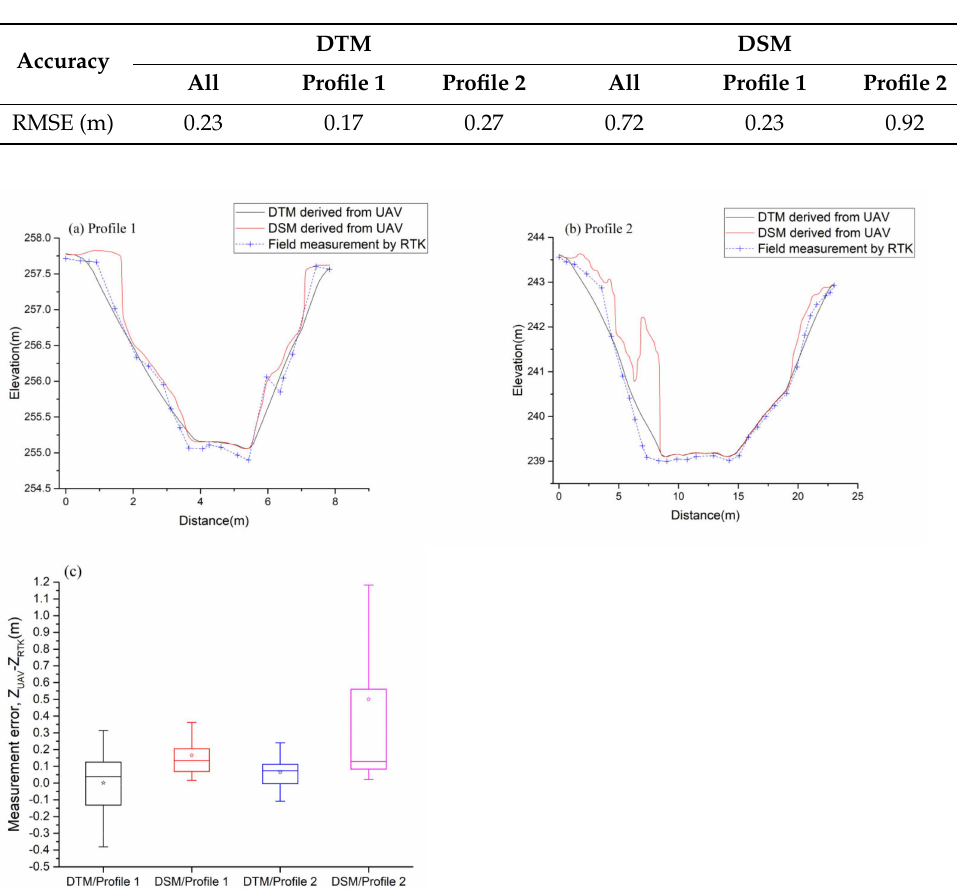
Table 3. Vertical differences in the RMSE between the geodetic measured points and the DTM/DSM points obtained from a UAV in 2019.